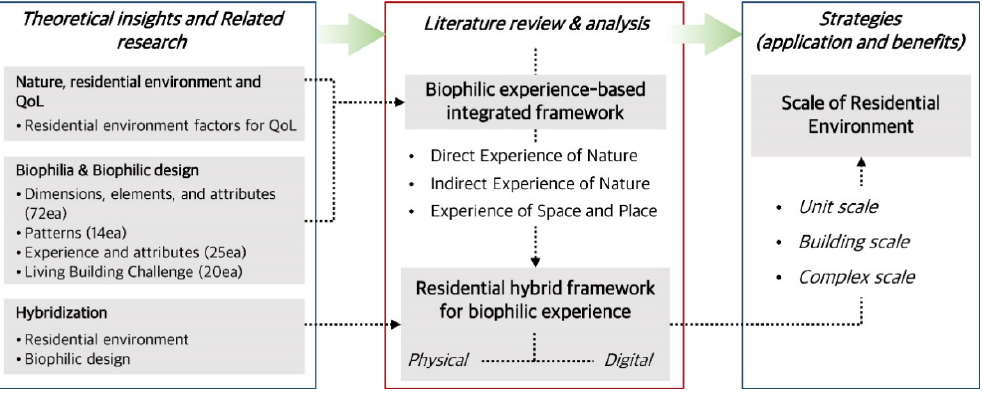
Figure 1. Research scheme.